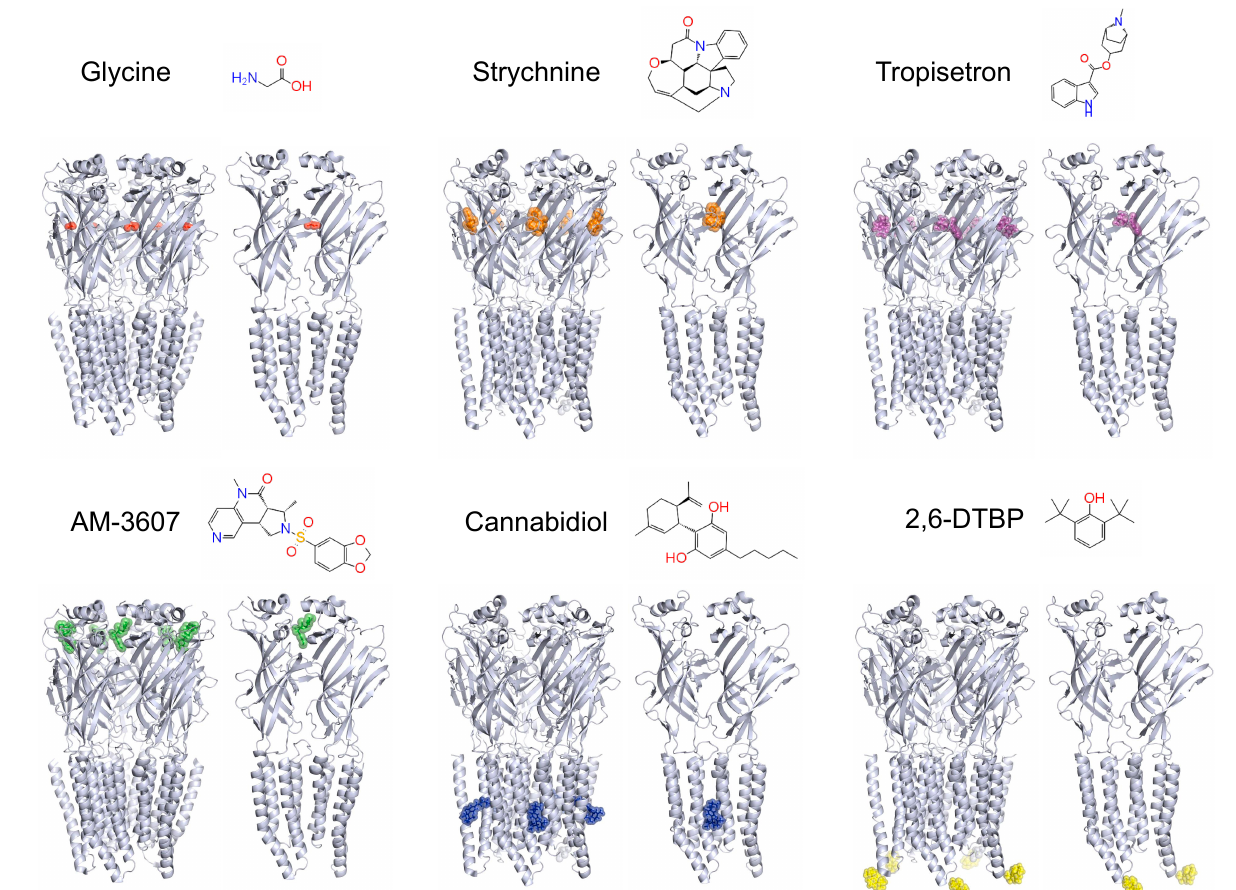
Figure 4. Modulators of α 3 GlyRs. Structures of α 3 GlyRs bound to the agonist glycine, the competitive antagonist strychnine, or the exogenous modulators tropisetron, AM-3607 (whose chemical structure is very similar to that of AM-1488), 2,6-di-tert-butylphenol (2,6-DTBP) and cannabidiol (CBD). To highlight the relevance of inter-subunit binding sites, models showing the interface of two adjacent α 3 subunits are also shown. The interaction of tropisetron with the orthosteric site of α 3 GlyRs was modeled according to [44]. The AM-3607 binding site was reconstructed as described in [11]. The models showing the CBD and 2,6-DTBP interaction with α 3 GlyRs were generated based on [12,14]. The α 3 GlyR structural coordinates (PDB ID: 5TIO and 5CFB) were taken from [11,45].